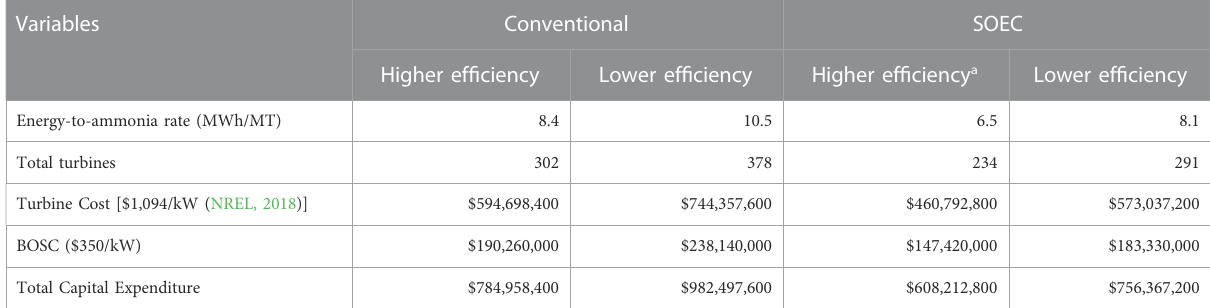
TABLE 2 Capital cost expenditures for turbines under alternative energy conversion rates to produce 248,188 MT of anhydrous ammonia per annum. Variables Conventional SOEC Higher ef fi ciency Lower ef fi